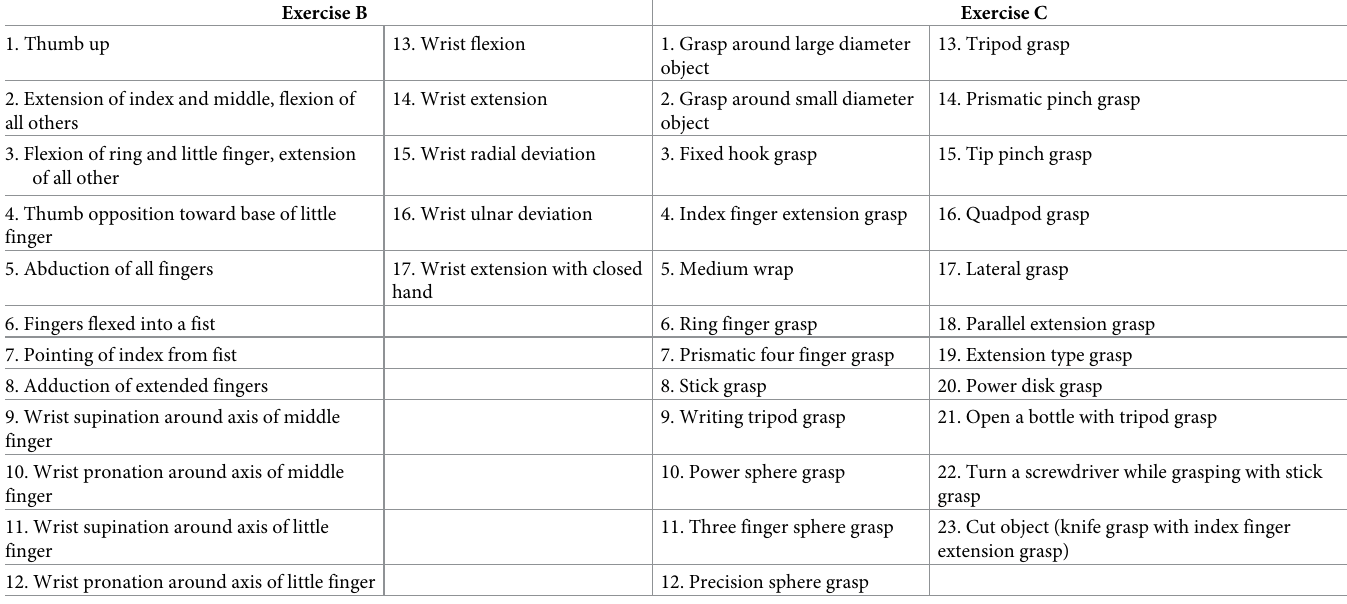
Table 2. Summary of movements and force patterns in each